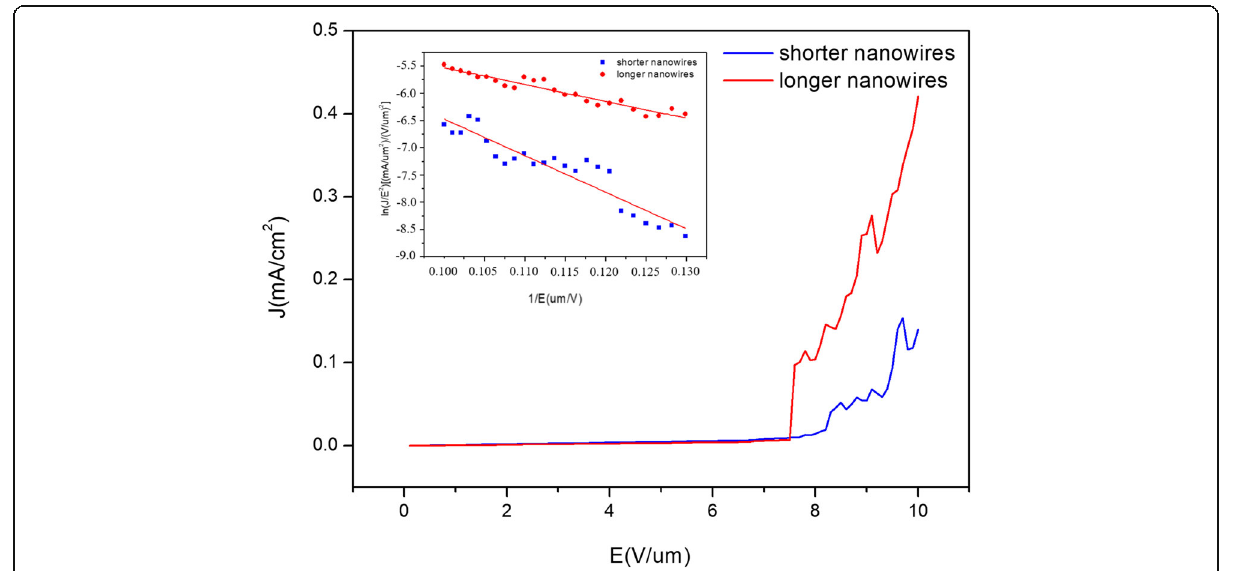
Fig. 5 The field emission plot of β -FeSi 2 NWs with different dimensions. The inset shows the corresponding ln( J / E 2 )-1/ E